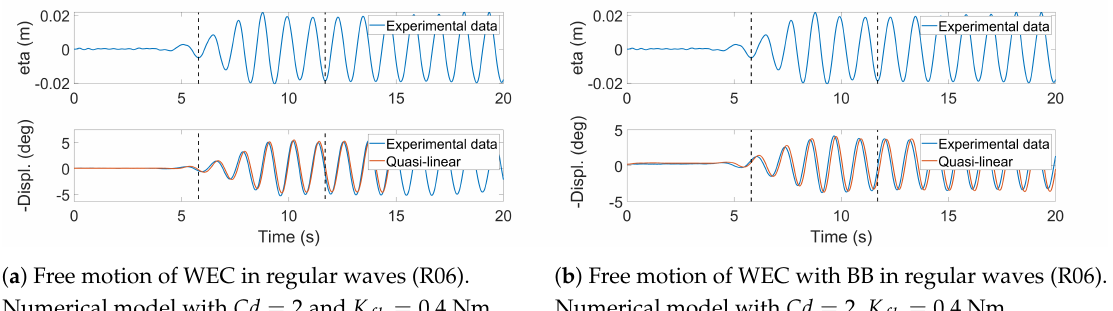
Figure 22. Comparison of time domain results to experimental data of the free motion of the WEC for a wave period equal to the calculated resonant period of the WEC using linear theory ( T = 1.2 s). Results for WEC only ( a ) and WEC with bottom ( b ) box are included.